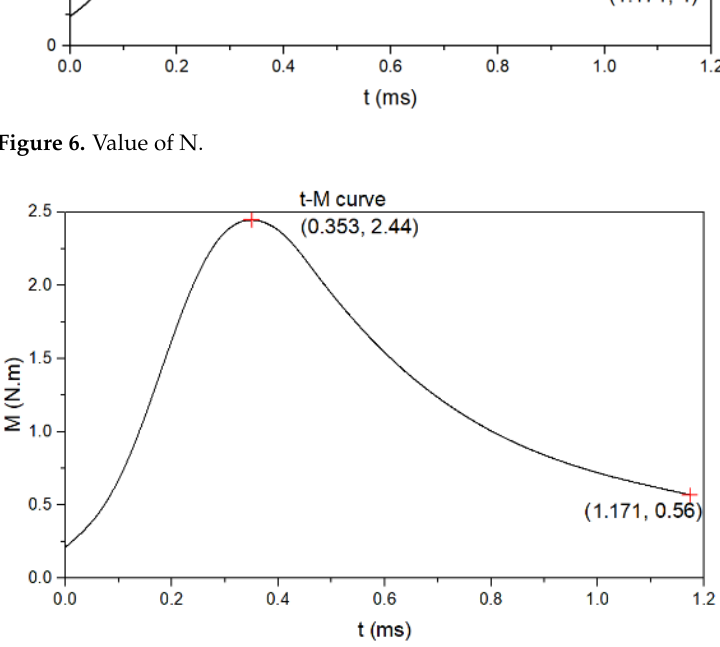
Figure 7. Value of M. The pressure of internal propellant gas belongs to the impact type of external force. The force on each rifling F 1 and the force on each rifling F 2 are shown in Figure 8.